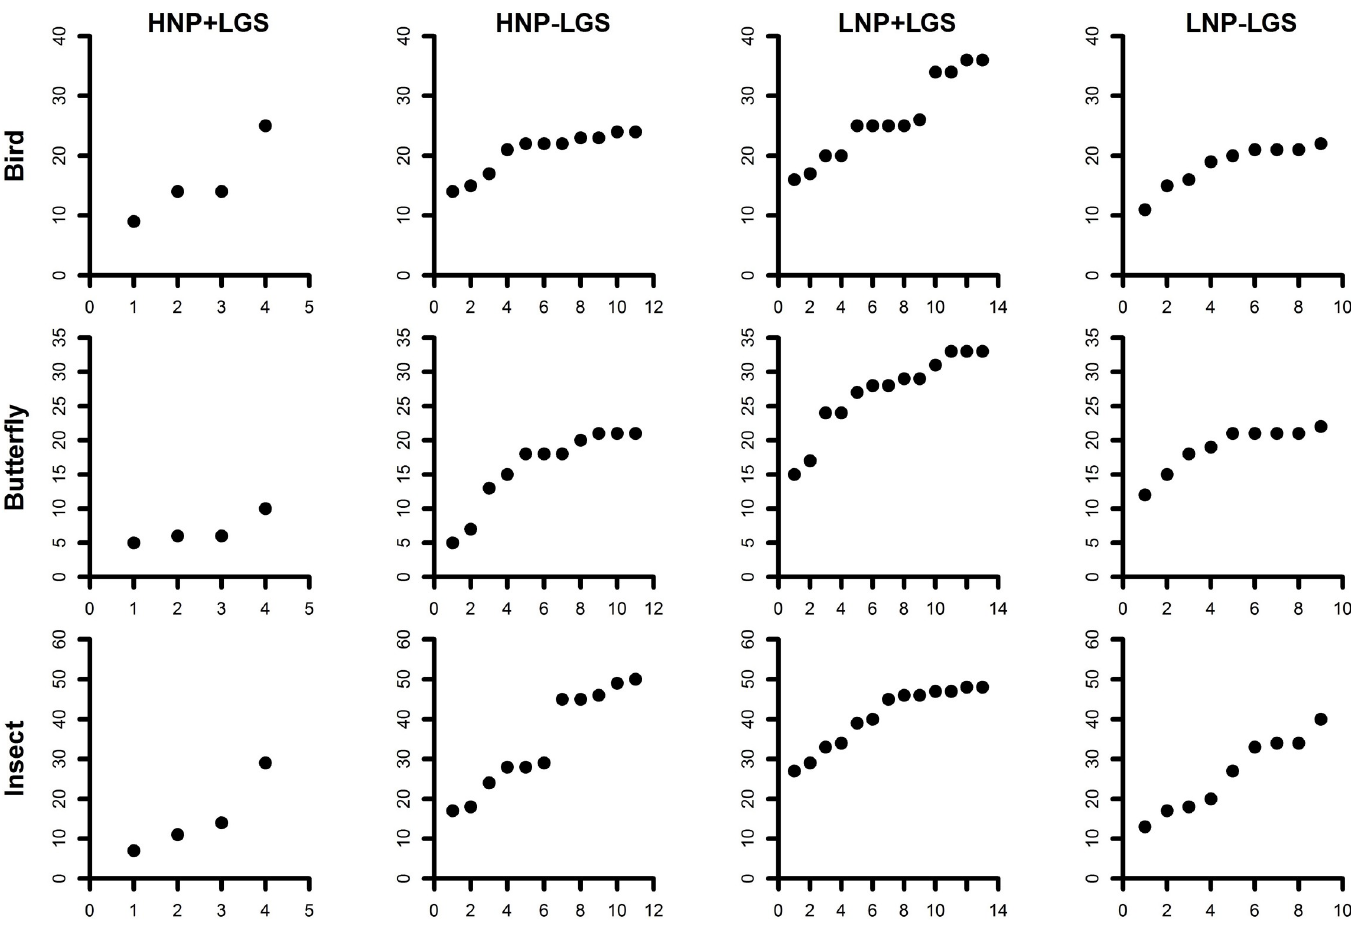
Fig 7. Species accumulation for three taxa across varying density of NPs at city scale.